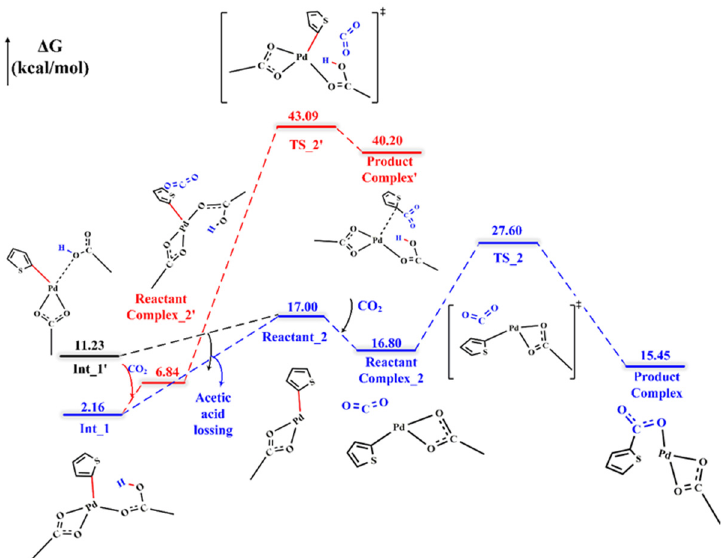
Figure 2. Reaction energy profiles of CO 2 insertion step: red curve for the case with the acetic acid; blue curve for the case with acetic acid removing.